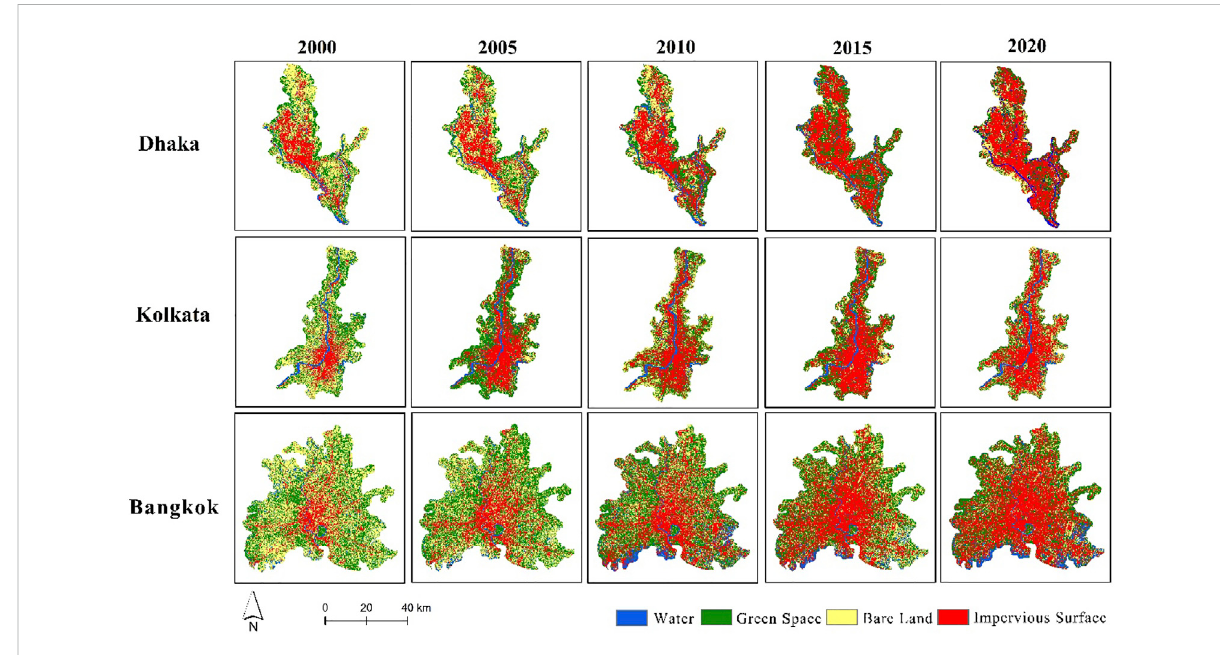
FIGURE 3 Land cover maps of the three megacities in 2000, 2005, 2010, 2015, and 2020.